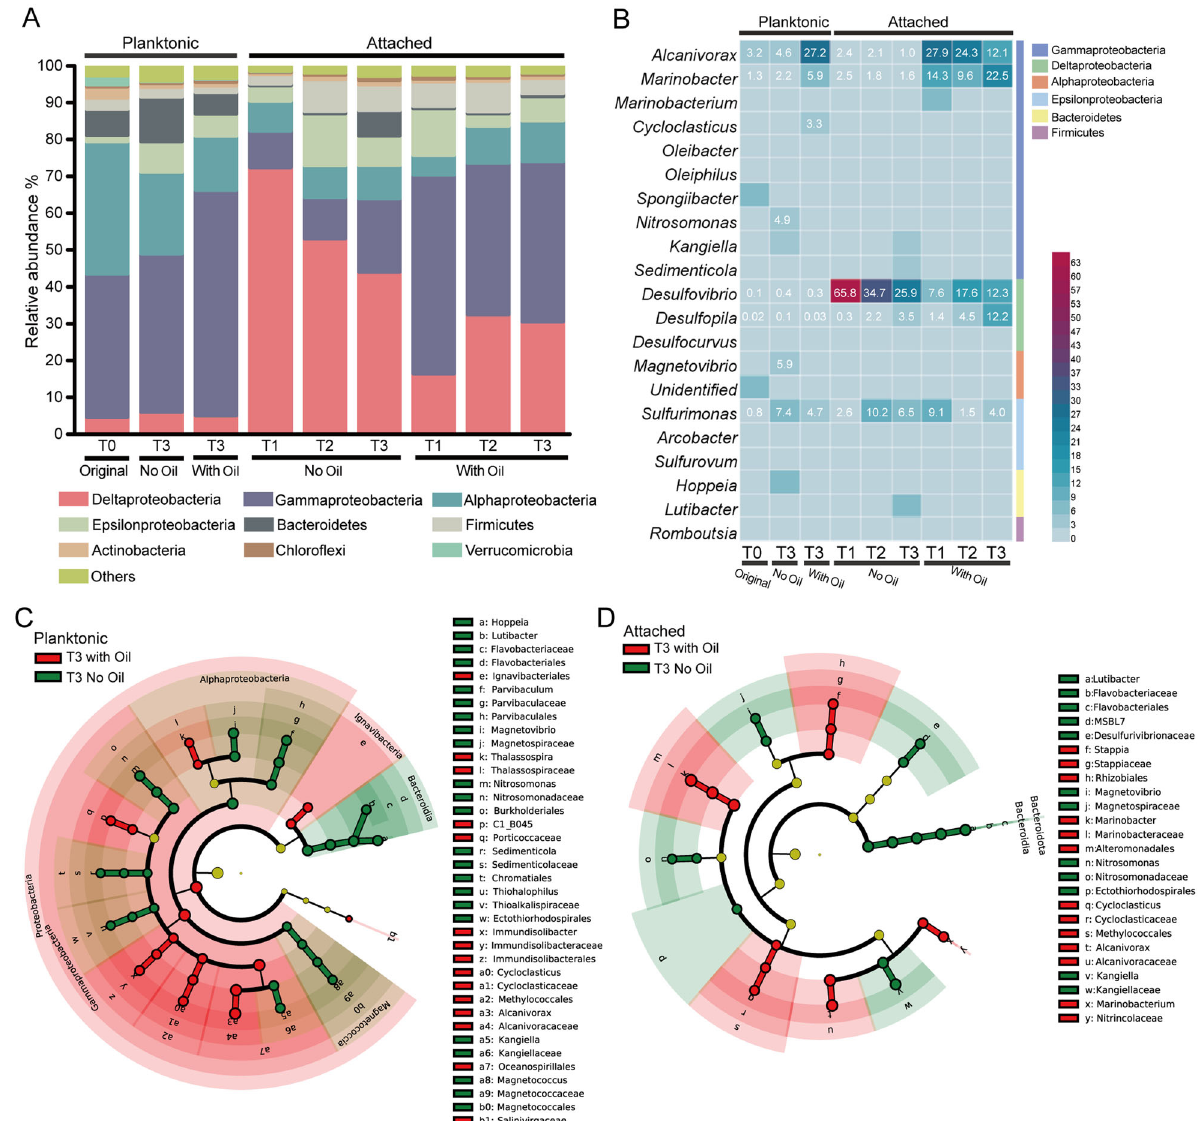
Fig. 5 Taxonomic composition of the planktonic and attached microbial community in seawater simulators during different culture stages with/without crude oil exposure. A Phylum (or class) level and B genus level composition analysis of top bacterial 16S rRNA gene sequences for seawater and surface samples. The cladogram of discriminatory taxa identi fi ed in the groups with/without crude oil from day 85 (T3) by LEfSe analysis (Linear Discriminant Analysis (LDA), log score > 3.5, P = 0.05). C Planktonic microbial communities from day 0 (T0) and day 85 (T3), and D the attached microbial communities from day 25 (T1), day 55 (T2), and day 85 (T3) were determined in laboratory microcosms with/without crude oil. The relative abundance of each taxonomy was the average value of that in triplicates. “ With Oil ” : With crude oil amendment; “ No Oil ” : Without crude